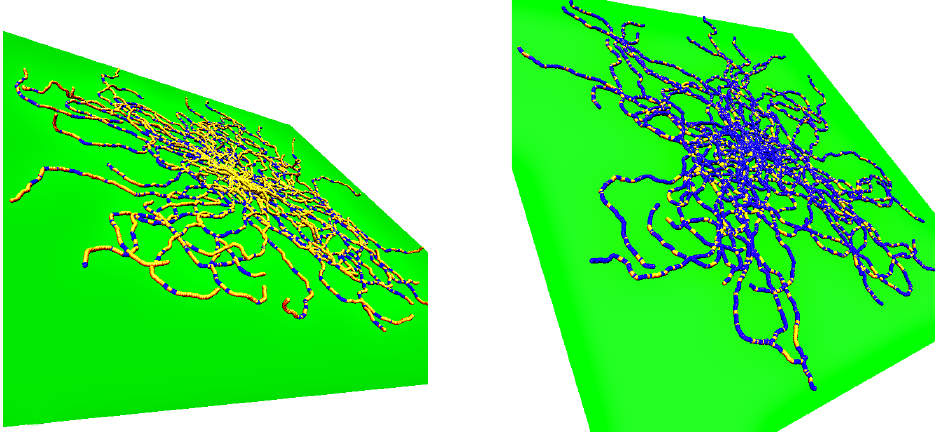
Figure 1. Snapshot pictures of N = 50 single semiflexible polymers, described by a bead-spring model, with N = 250 monomers each for the case of a chain stiffness κ = 25 and wall potential depth (cid:101) wall = 0.60 ( left ) and 0.80 ( right )—see Section 2 for a precise description of the chosen model. The adsorbing surface is shown in green, and monomeric units within the range of the adsorption potential are shown in blue while those outside of this range are shown in yellow. Note that the root (cid:113) (cid:104) R 2 = 0.60, and about 0.48 (cid:105) is only about 2.14 for (cid:101) mean square gyration radius in the z -direction gz wall for (cid:101) wall = 0.80, implying that in both cases the polymer conformations are almost two-dimensional (cid:113) (cid:104) R 2 (cid:105) ≈ 48 in both cases. All chains are grafted at the point x = 0, y = 0, z = 0.97 so the while || g superposition of the snapshots should not be confused with pictures of star